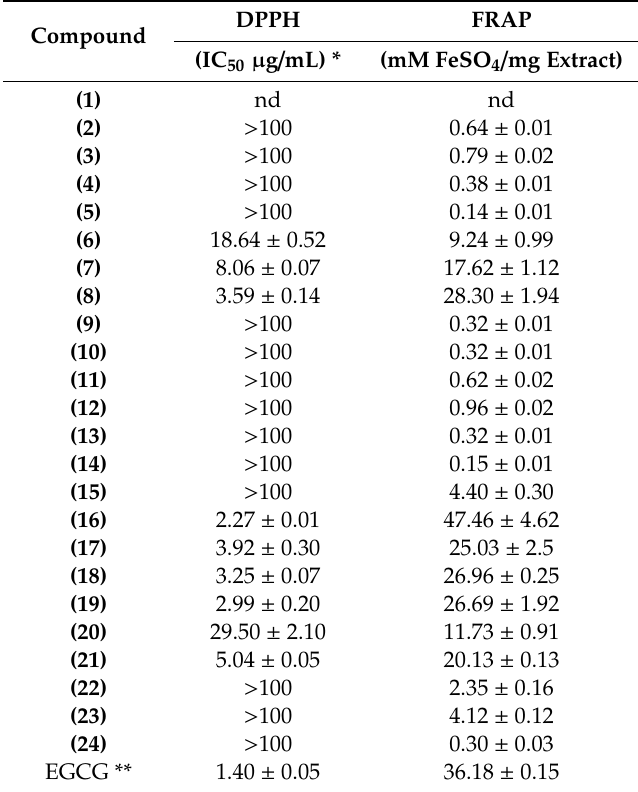
Table 2. In vitro antioxidant activities: DPPH and FRAP for the isolated compounds. Compound